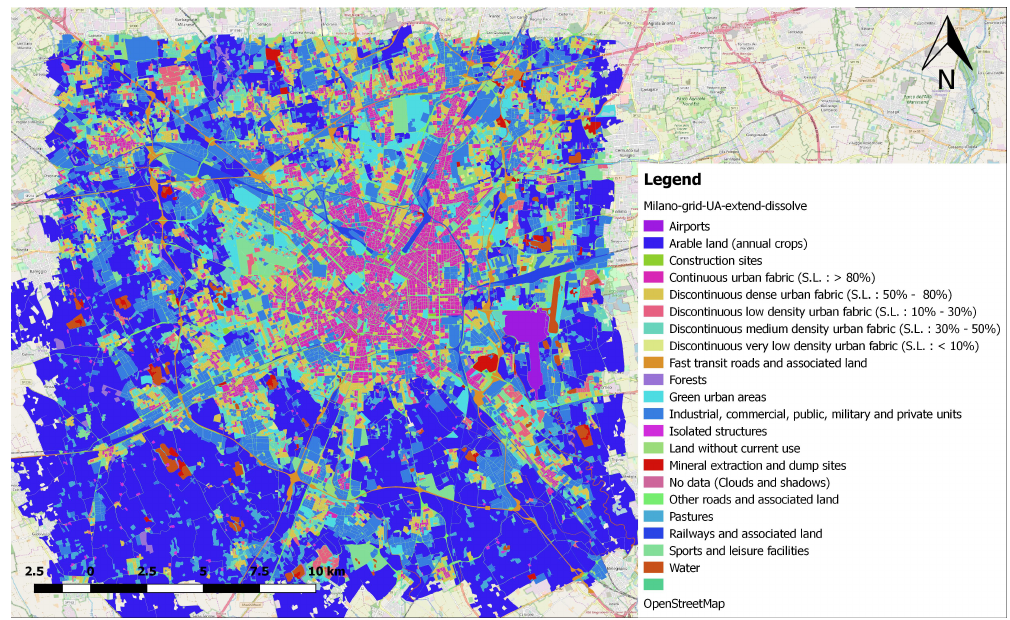
Figure 3. Land use classes over the extended spatial area of Milan.